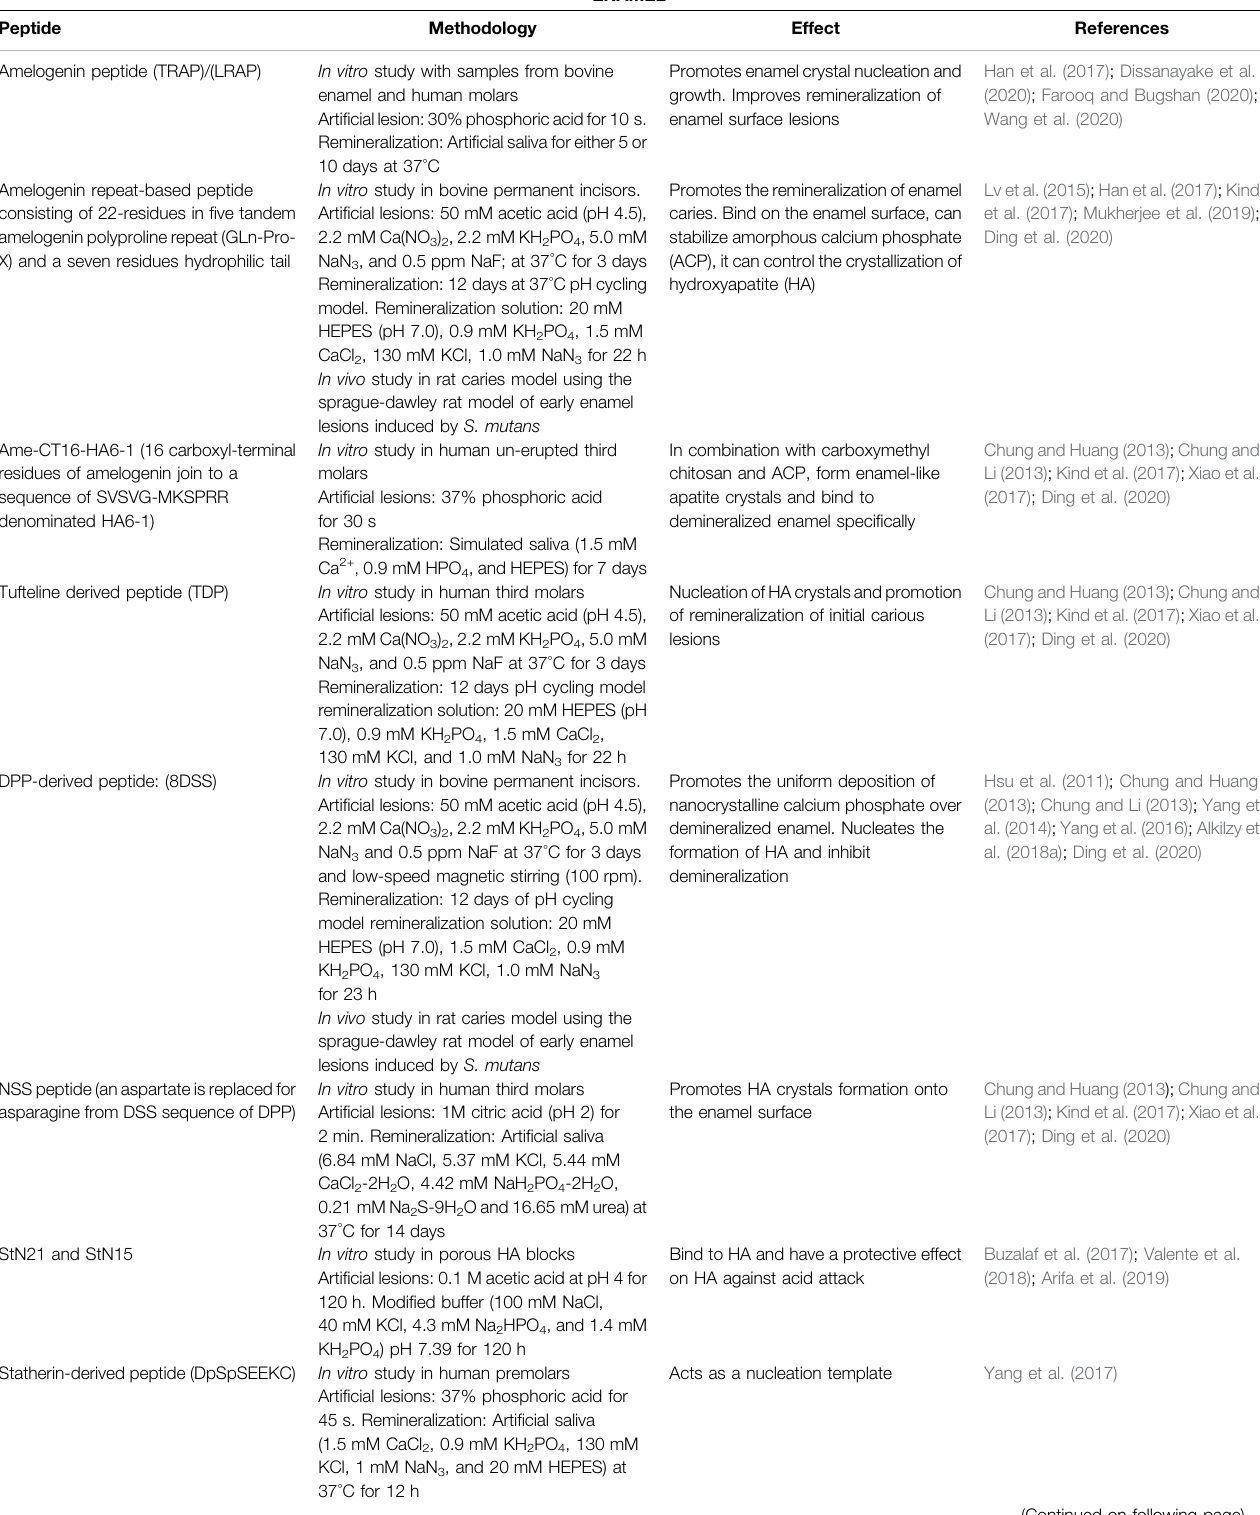
TABLE 1 | Synthetic peptides used for dental tissue